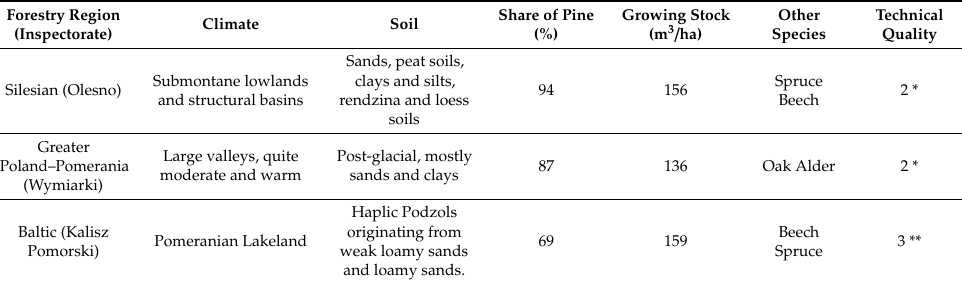
Figure 1. Location of research material collection sites: Site 1—Silesian Forestry Region; Site 2—Greater Poland–Pomerania Forestry Region; Site 3—Baltic Forestry Region. Table 1. Habitat and geographical origin characteristics.